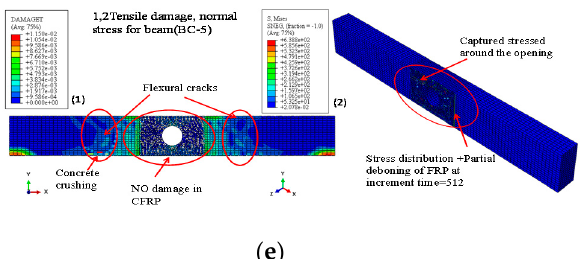
Figure 13. FE result for mode failure of specimens, comparison with the experimental results: ( a ) B-0, ( b ) BC-1, ( c ) BC-2, ( d ) BC-3, ( e ) BC-5.